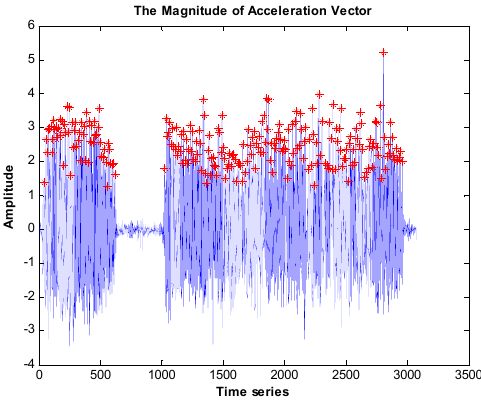
Figure 4. An example of step detection: where the blue line is the acceleration measurement and the red dots are the detected steps.